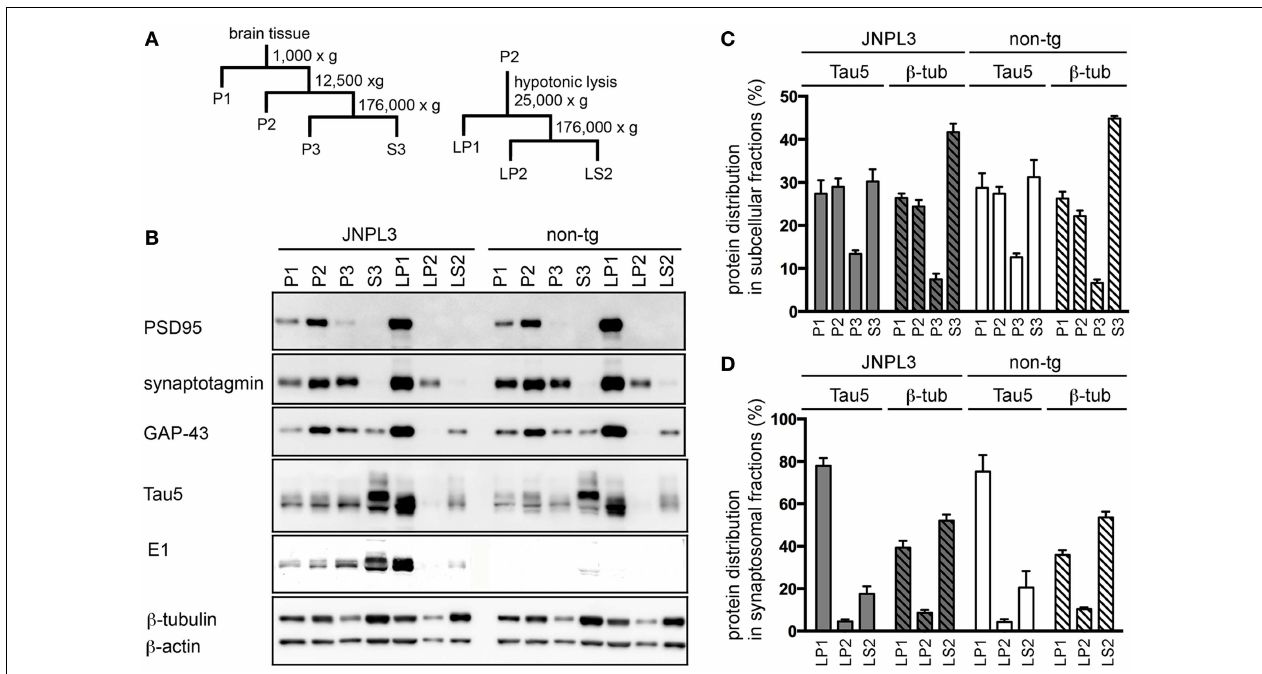
(C) Proportions of protein levels in fractions (P1, P2, P3, and S3) of tau (Tau5) and β -tubulin ( β -tub) from JNPL3 ( n = 5) and non-tg ( n = 5) mice are shown. Intensities of tau (49–65kDa) and β -tubulin (50kDa) were measured by Bio-Imaging Analyzer System. Ratios were indicated by percent of total (P1 + P2 + P3 + S3). Results are expressed as mean ± SEM. (D) Proportions of protein levels in synaptosomal fractions (LP1, LP2, and LS2) of tau (Tau5) and β -tubulin ( β -tub) from JNPL3 ( n = 5) and non-tg ( n = 5) mice were indicated. Intensities of tau (49–65kDa) and β -tubulin (50kDa) were measured by Bio-Imaging Analyzer System. Ratios were indicated by percent of total (LP1 + LP2 + LS2). Results are expressed as mean ±